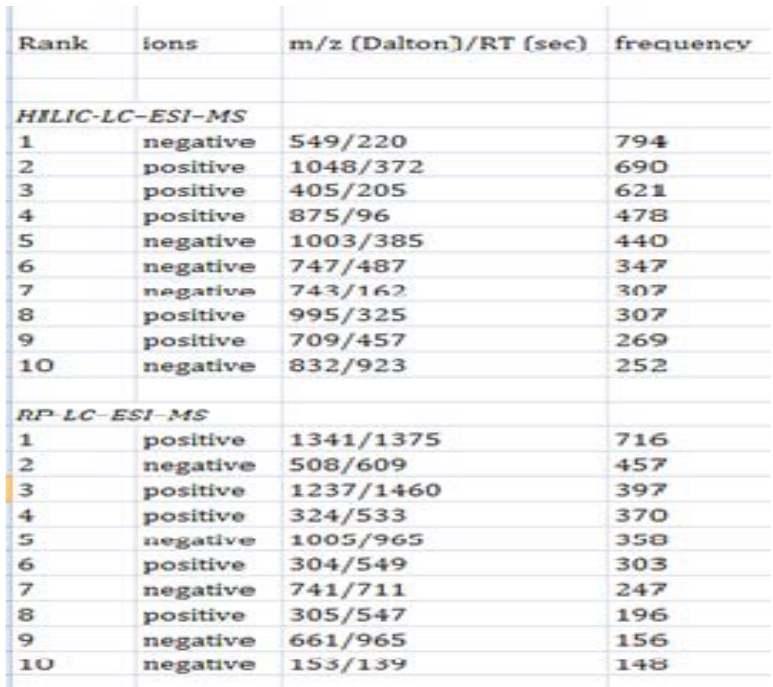
Table 2. Top 10 classifiers from HILIC-LC-ESI-MS and RP-LC-ESI-MS datasets (XCMS peak lists).